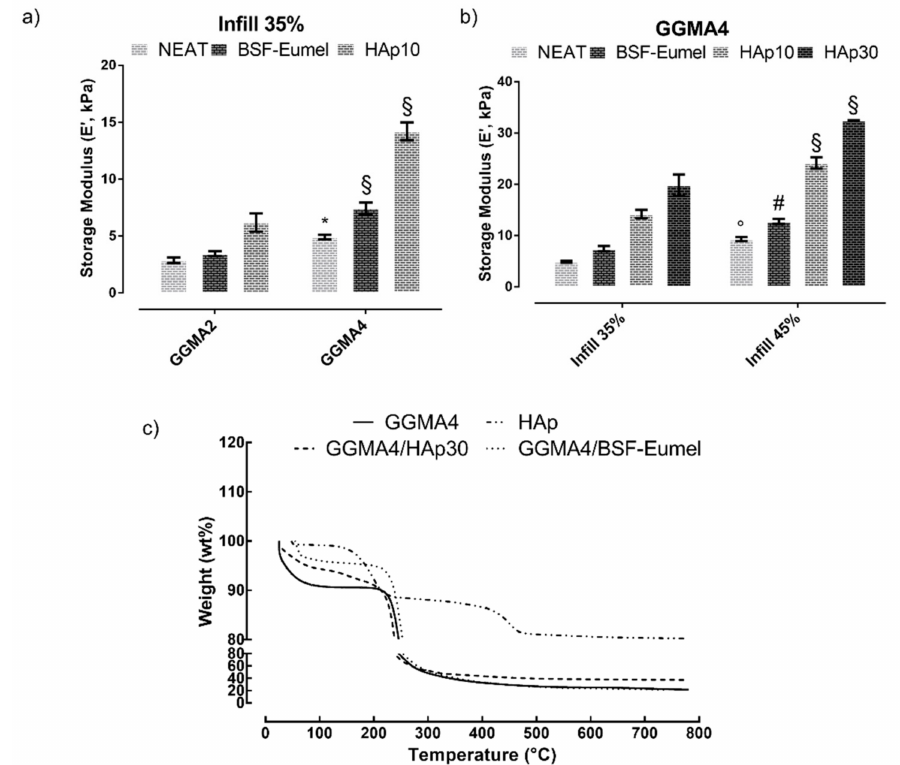
Figure 4. ( a ) GGMA concentration (2–4% ( w / v )) effect on the storage modulus, by dynamic mechan- ical analysis (DMA), fixing the infill at 35% among the different scaffolds. ( b ) Infill effect on the storage modulus of GGMA-based scaffolds, by DMA, fixing the GGMA concentration at 4% ( w / v ). ( c ) Thermogravimetric analysis of HAp and GGMA4-based scaffolds performed under N 2 flow, heating from 25 to 800 ◦ C at 10 ◦ C/min. Statistical analysis of variance on mean values was assessed by one-way ANOVA followed by Tukey’s post hoc test with multiple comparisons. (Histograms (mean value ± S.E.M.) with * p < 0.05, ◦ p < 0.01, # p < 0.001, § p <